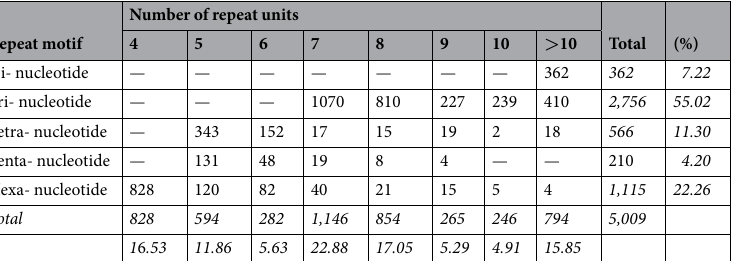
Table 4. Summary of EST-SSRs and their repeat motif isolated from Capparis spinosa leaf